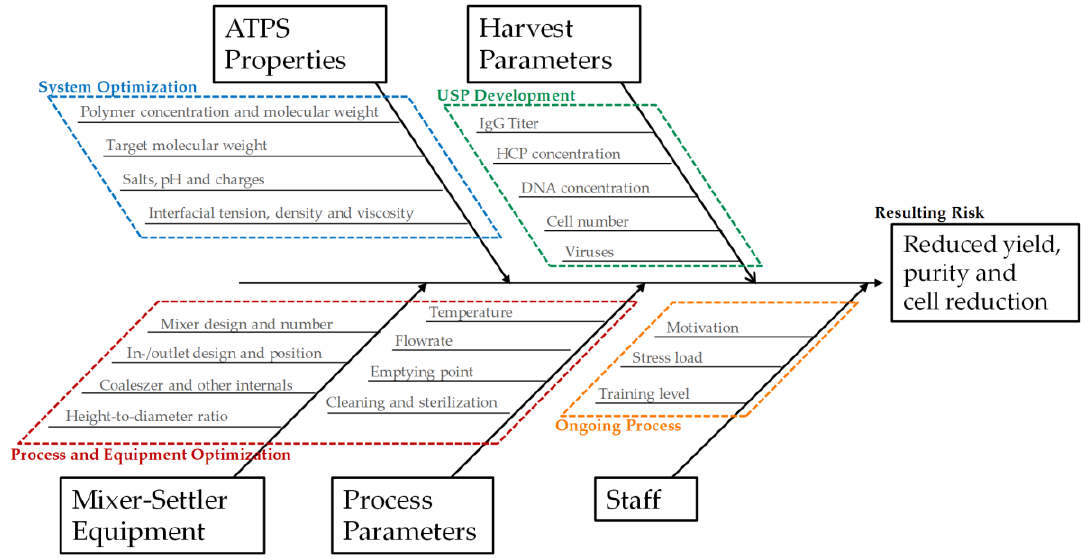
Figure 3. Ishikawa diagram illustrating the main groups of causes affecting yield, purity, and cell reduction in the outlined ATPE process. ATPS: separated aqueous two-phase system; HCP: host cell proteins.